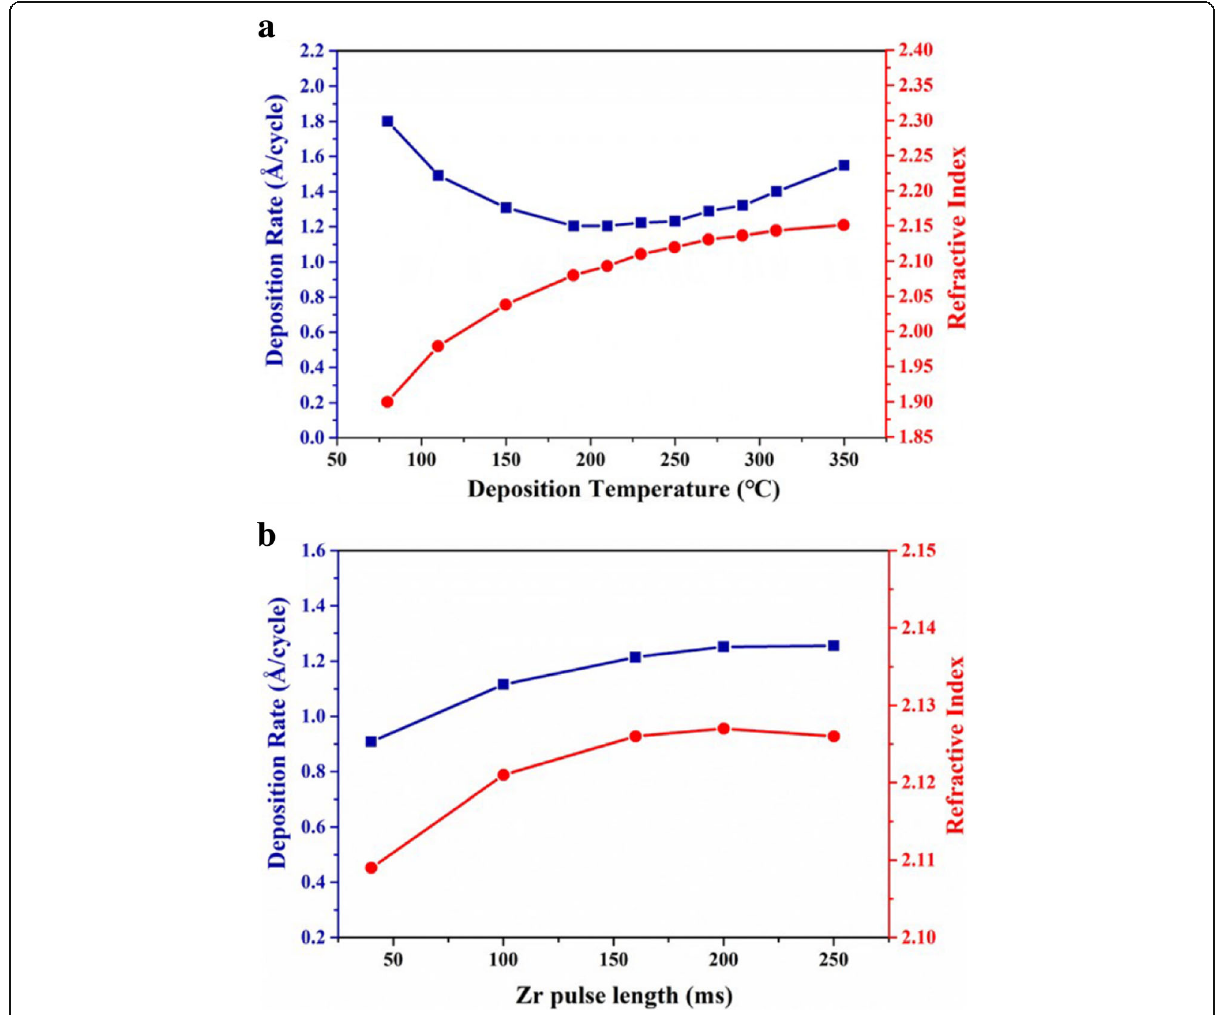
Fig. 1 The changes of deposition rate and refractive index for ZrO 2 thin films as a function of deposition temperature ( a ) and Zr precursor pulse time ( b